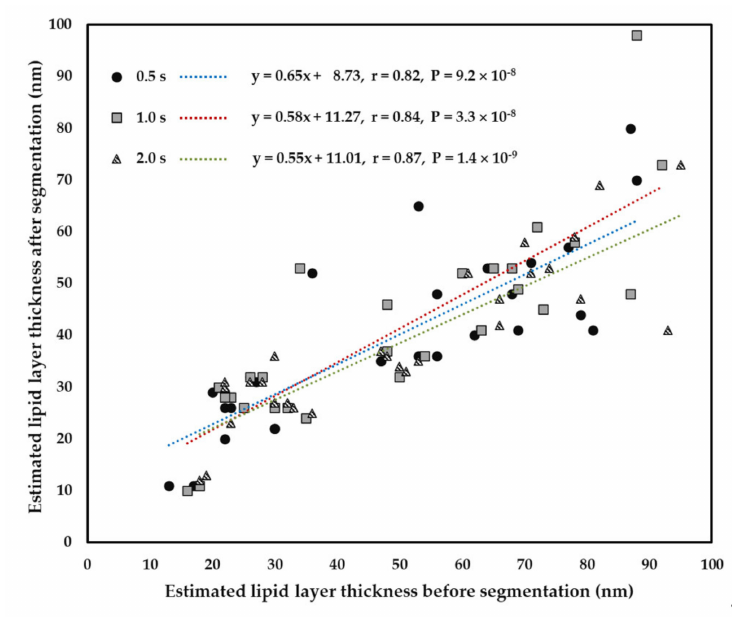
Figure 6. Transformed LLT based on the pre-segmentation LLT for predicting post-segmentation LLT by general linear model (at 0.5 s, the transformed LLT = pre-segmentation LLT × 0.65 + 8.73; at 1.0 s, the transformed LLT = pre-segmentation LLT × 0.58 + 11.27; at 2.0 s, the transformed LLT = pre-segmentation LLT × 0.55 + 11.01). Total number of subjects were 28 ( N = 28).